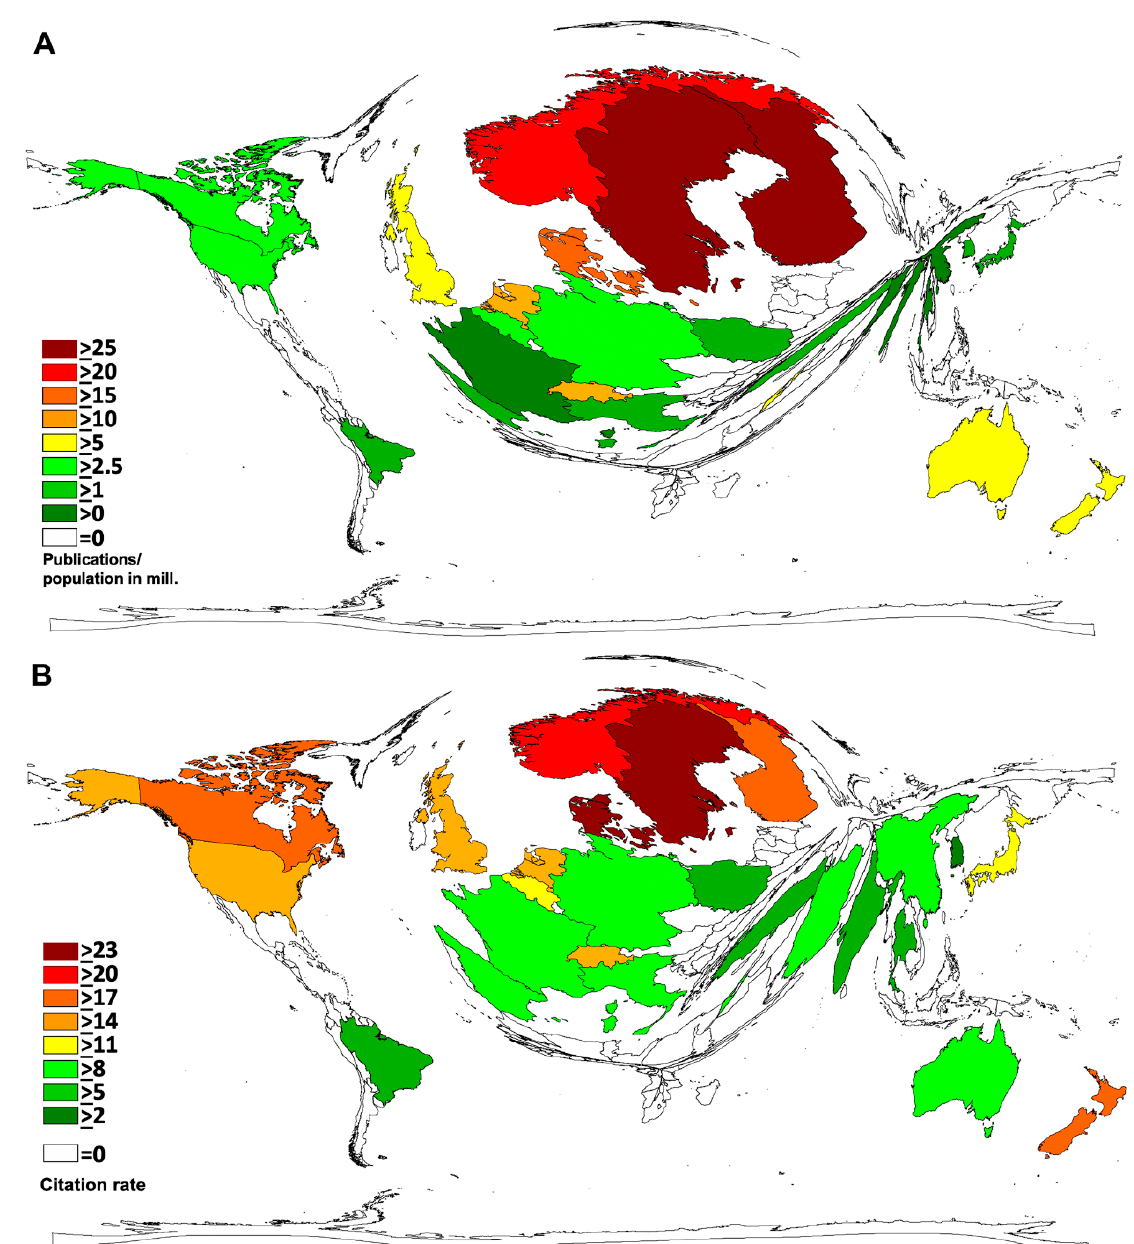
Figure 3. Socio-economic parameters. ( A ) R POP = number of articles per population in millions [16] (threshold value: >30 articles). ( B ) R GDP = number of items per gross domestic product (GDP) in USD 1000 billion [16] (threshold value > 30 articles).